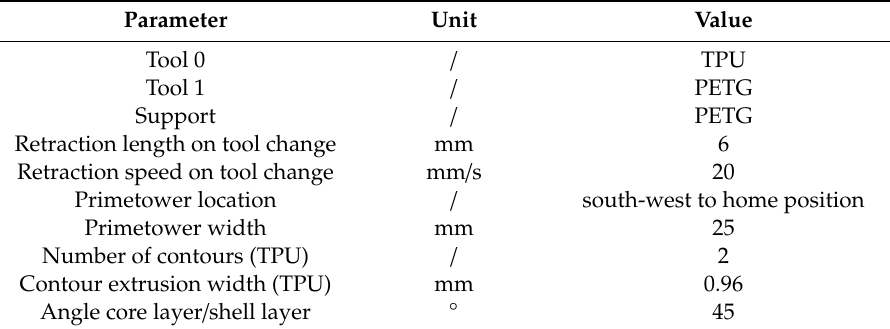
Table 8. Dual printing parameters [7].